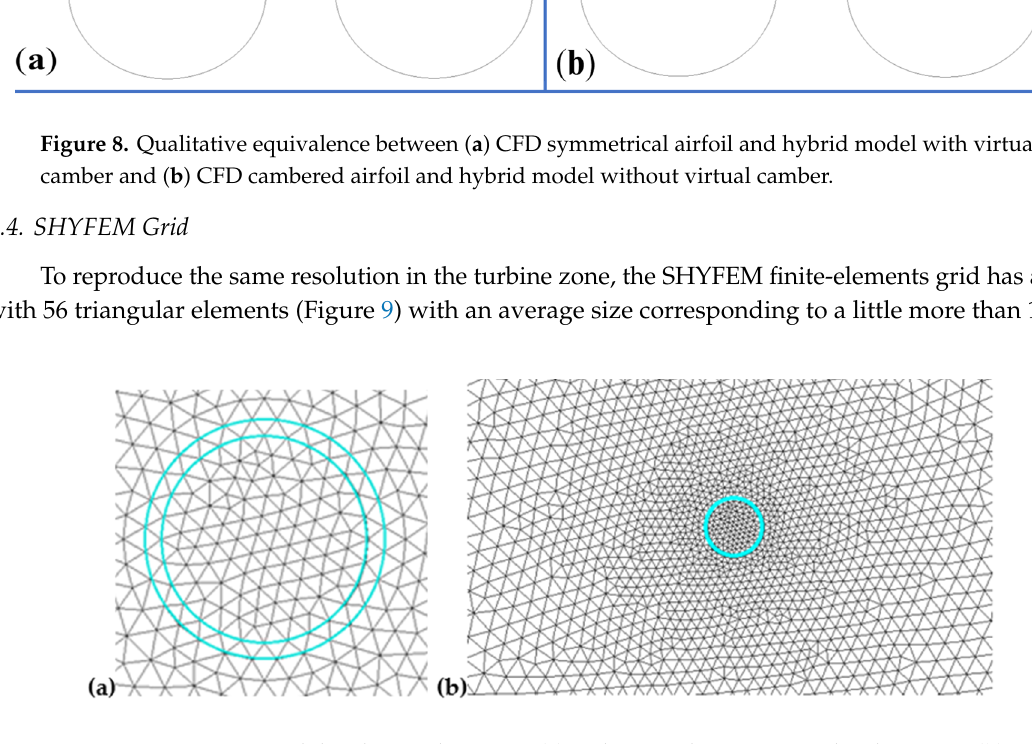
Figure 9. SHYFEM grid details in turbine zone ( a ) and in a wider area around turbine zone ( b ).